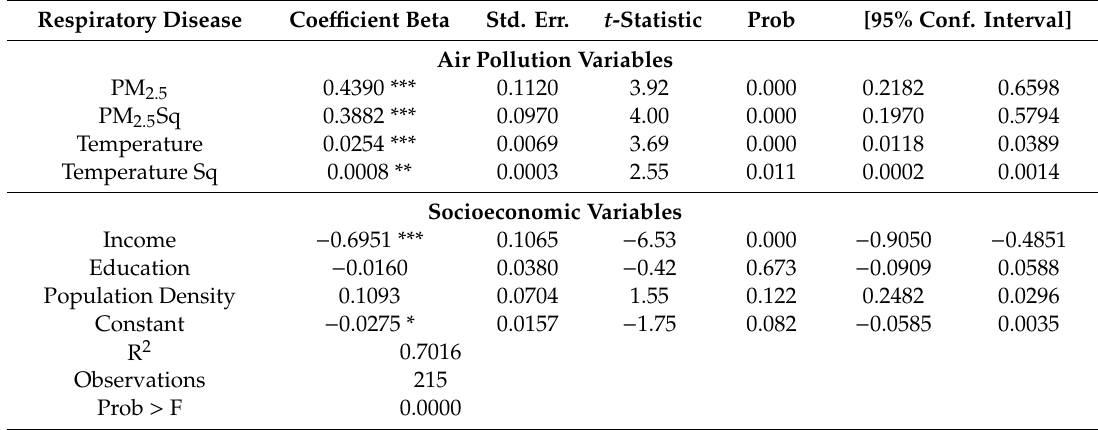
Table 4. Fixed-e ff ect